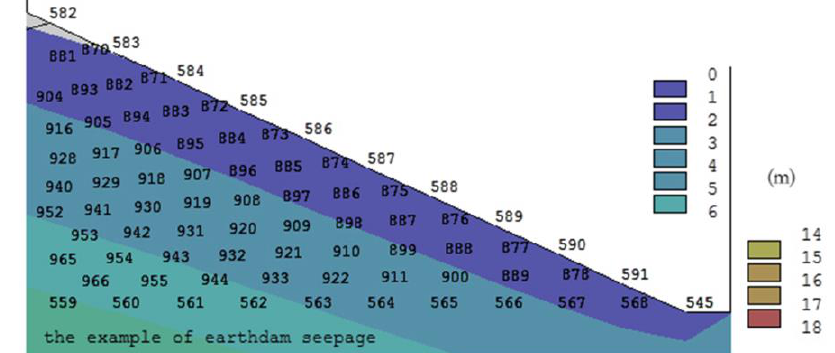
Figure 3. Downstream slope nodes.